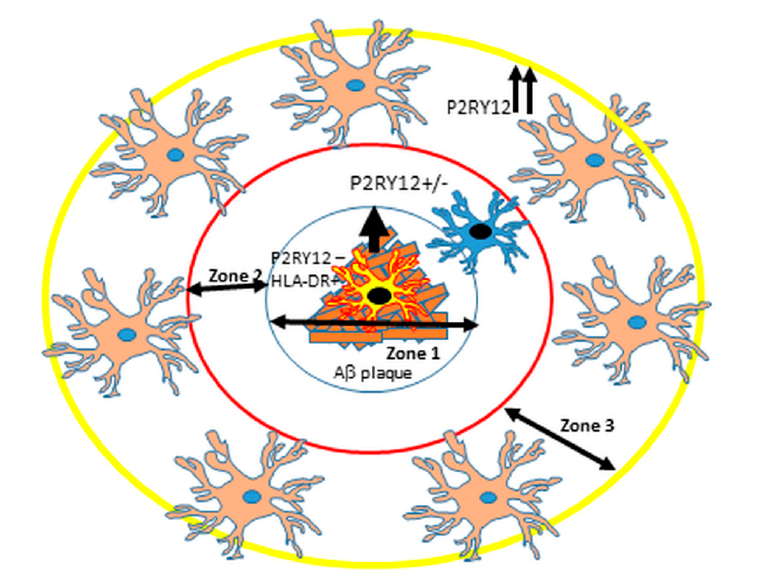
Figure 12. Proposed scheme of arrangement of di ff erent P2RY12-expressing microglia around A β plaques. Suggested scheme to describe localized areas of microglial inflammation around plaques. Zone 1: microglia interacting with mature plaques (HLA-DR high, P2RY12 negative) producing proinflammatory cytokines. Zone 2: Area adjacent to plaque with low or negative P2RY12 positive microglia. Zone 3. P2RY12 high expression in surrounding area defining the boundary between proinflammatory area (Zone 1 and 2) and non-a ff ected area (Zone 3 and beyond). As described in this report, exceptions to this scheme were